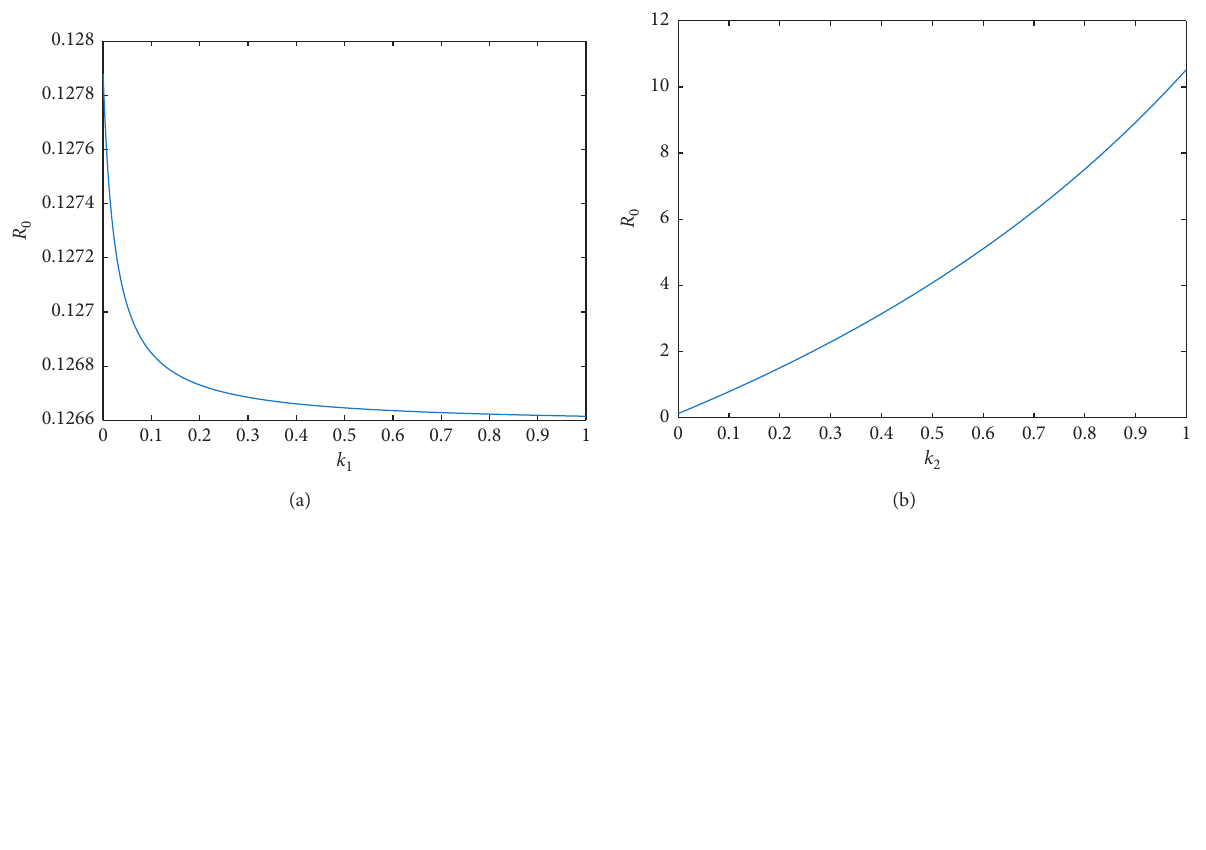
∗ with an initial value I 3 . (b) The stability of E 4